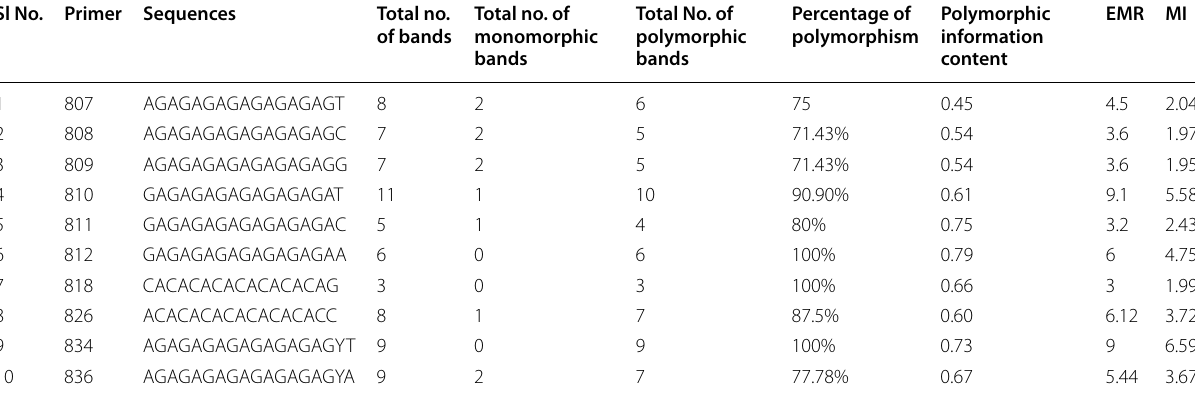
Table 3 Result of different genetic expressions of Phoebe goalparensis showing the percentage of monomorphism and Polymorphism, PIC, EMR and MI Sl No. Primer Sequences Total no.